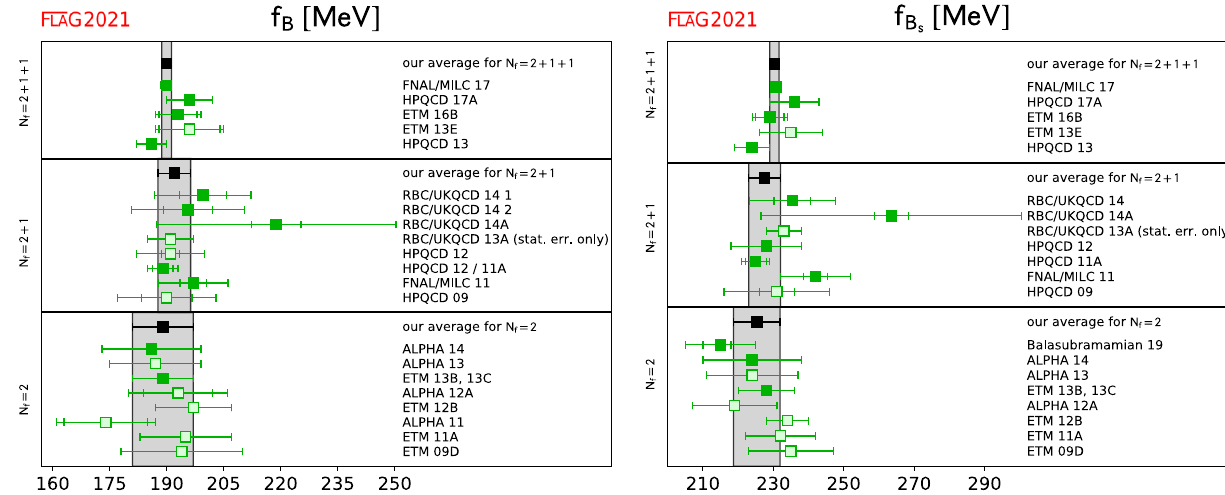
Fig. 27 Decay constants of the B and B s mesons. The values are taken from Table 41 (the f B entry for FNAL/MILC 11 represents f B + ). The significance of the colours is explained in Sect. 2. The black squares and grey bands indicate our averages in Eqs. (207), (210), (213), (208), (211) and